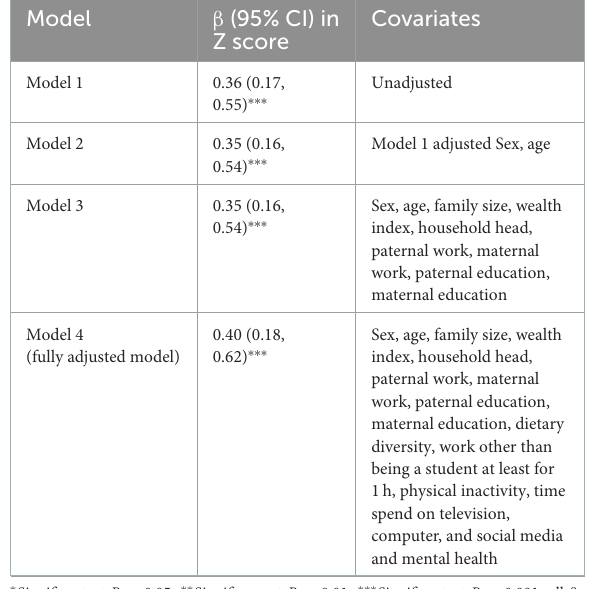
TABLE 3 Multivariable linear regression models predicting mean baseline to end line differences of the differences in BAZ score among school feeding and non-school feeding groups of adolescents in Addis Ababa and Adama, Central Ethiopia,